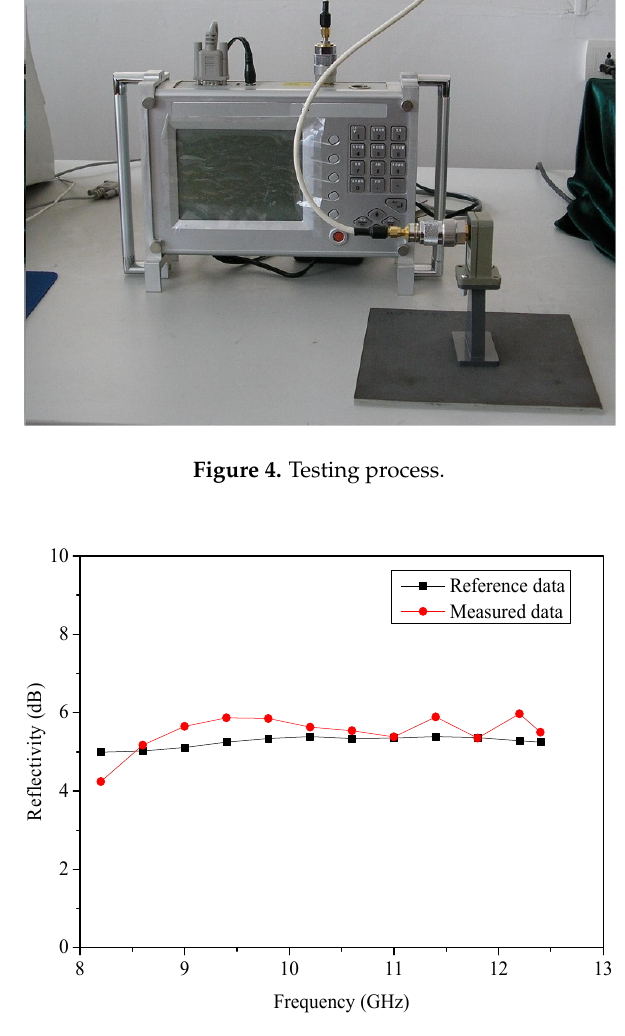
Figure 5. Experimental results of absorbing material coating #1. Coatings 2017 , 7 , 38